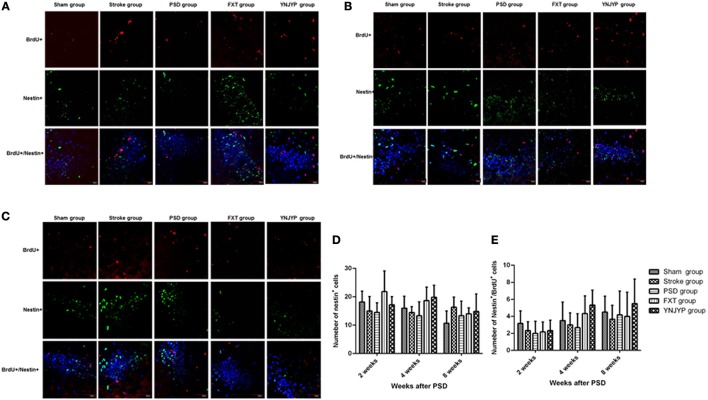
Effects of treatments on neural stem cell proliferation in PSD rats at 2, 4, and 8 weeks post-stroke. To observe the proliferation of neural stem cells (NSCs), newly formed cells were labeled with BrdU (red) and NSCs were labeled with nestin (green) at 2, 4, and 8 weeks post-stroke. Cell nuclei were labeled with 4′,6-diamidino-2-phenylindole (blue). (A) At 2 weeks post-stroke. (B) At 4 weeks post-stroke. (C) At 8 weeks post-stroke. Scale bar = 30 μm. (D) The number of nestin-positive cells at the observed dentate gyrus zone (at 2 weeks: F = 2.274, P = 0.090; at 4 weeks: F = 2.563, P = 0.063; at 4 weeks: F = 1.314, P = 0.292). (E) The number of cells double-positive for nestin and BrdU appeared at the dentate gyrus (at 2 weeks: F = 0.754, P = 0.565; at 4 weeks: F = 2.086, P = 0.113; at 8 weeks: F = 0.488, P = 0.745). BrdU, 5-bromo-2-deoxyuridine; PSD, post-stroke depression; FXT, fluoxetine hydrochloride capsules; YNJYP, Yi-nao-jie-yu prescription.